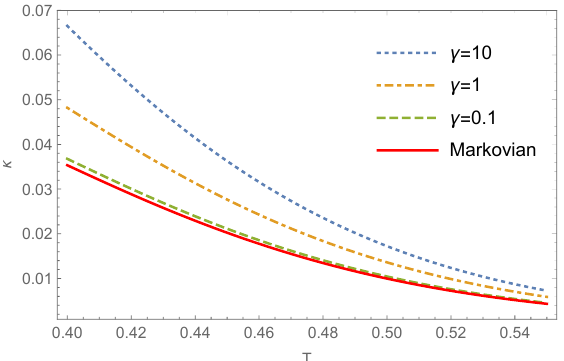
Figure 5 . The dependence of the transition rate of the Hawking-Page phase transition from the large SAdS black hole state to the thermal AdS state on the ensemble temperature T for the exponentially decayed friction kernel. In the plot, L = 1 and ζ = 2